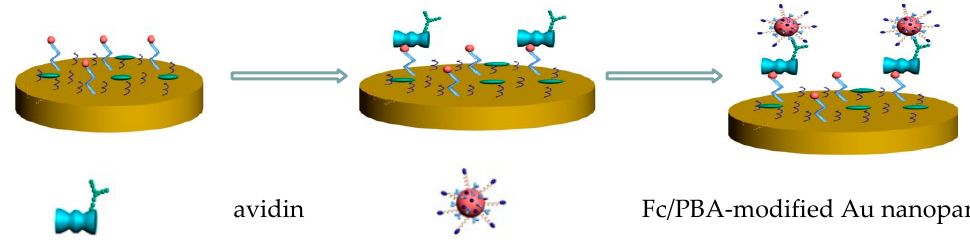
Figure 7. Avidin sensor based on Fc/PBA-modified Au nanoparticles. Reprinted from Xing et al. [99].